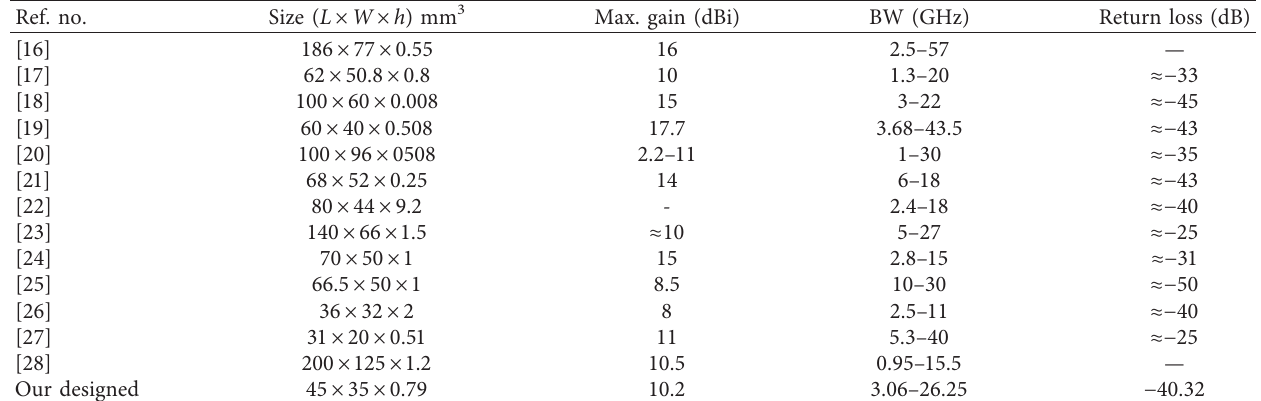
Table 3: Comparison with some recently published works.